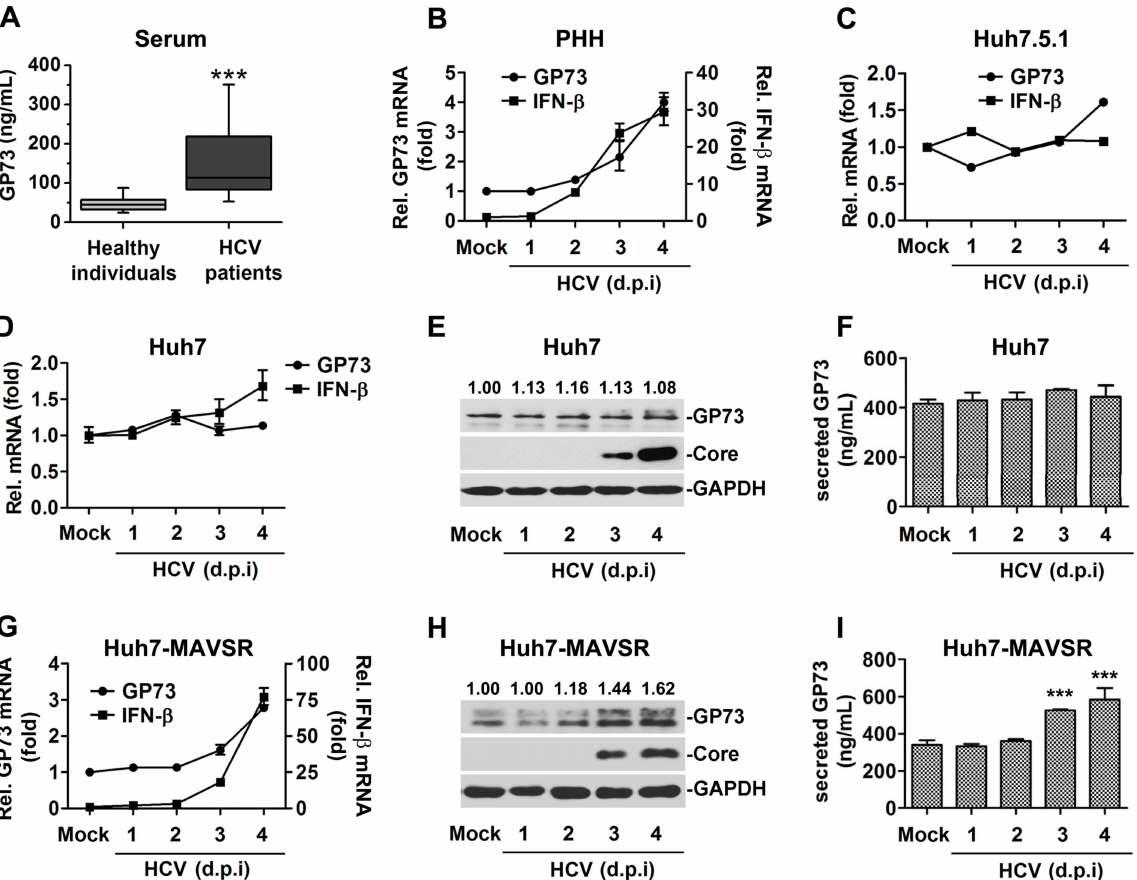
Fig 1. GP73 expression is activatedand correlated with IFN activation during HCV infection. ( A )SerumGP73 levelsin HCV- infected patients (n = 60) and healthyindividuals(n = 60) weredetectedby ELISA. Samplesweretested in duplicate and concentrations were determined from standardcurves. Data representmeans ± SEM. Boxplotsillustratemedianswith 25% and 75% and error barsfor 5% and 95% percentiles. ( B,C )Primary humanhepatocytes (PHHs)( B )or Huh7.5.1cells ( C )were infectedwith HCV at a multiplicityof infection(MOI) of 2 for indicatedtimes. GP73 and IFN- β mRNAs werequantifiedby RT-PCR. ( D , E , and F ) Huh7cells were infected with HCV at MOI = 2 for indicatedtimes. The mRNA levelsof GP73 and IFN- β weredeterminedby RT-PCR ( D ),the protein levelsof GP73 weredetermined by WB ( E )and ELISA ( F ).( G , H , and I ) Huh7-MAVSR cells were infectedwith HCV at MOI = 2 for indicated times. The mRNA levelsof GP73 and IFN- β weredetermined by RT-PCR( G ),the proteinlevelsof GP73 weredeterminedby WB ( H ) and ELISA ( I ).Bar graphsrepresent means ± SD, *** P < 0.001,comparedwith controlgroup. (d.p.i, days post